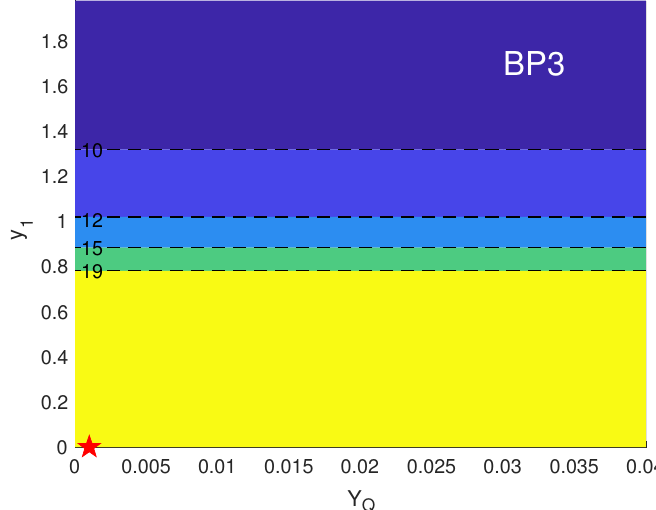
Figure 10. Vacuum instability scales in ( Y Q , y 1 ) plane in benchmark points BP1 – BP3 . The red star corresponds to the chosen benchmark point value. The color coding and the contour numbers are interpreted as in Figure